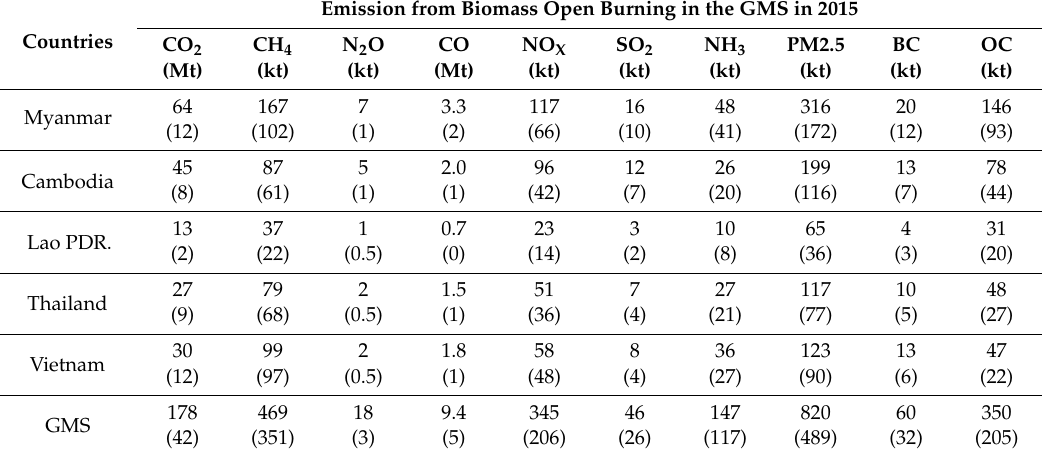
Table 6. The actual amount of emissions from biomass open burning in the GMS in 2015 (standard error in